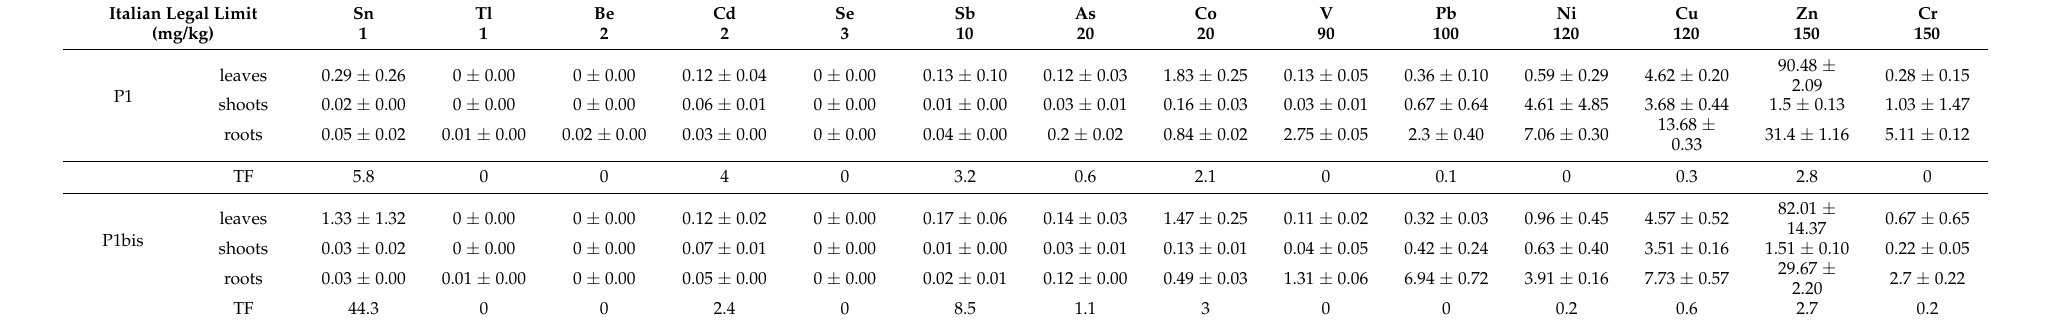
Table 6. Heavy metal concentrations (average values ± standard deviation) detected in plant tissues (leaves, shoots, and roots) at 900 days after poplar plantation from the P1 and P1bis plants. TF: translocation factor value for each